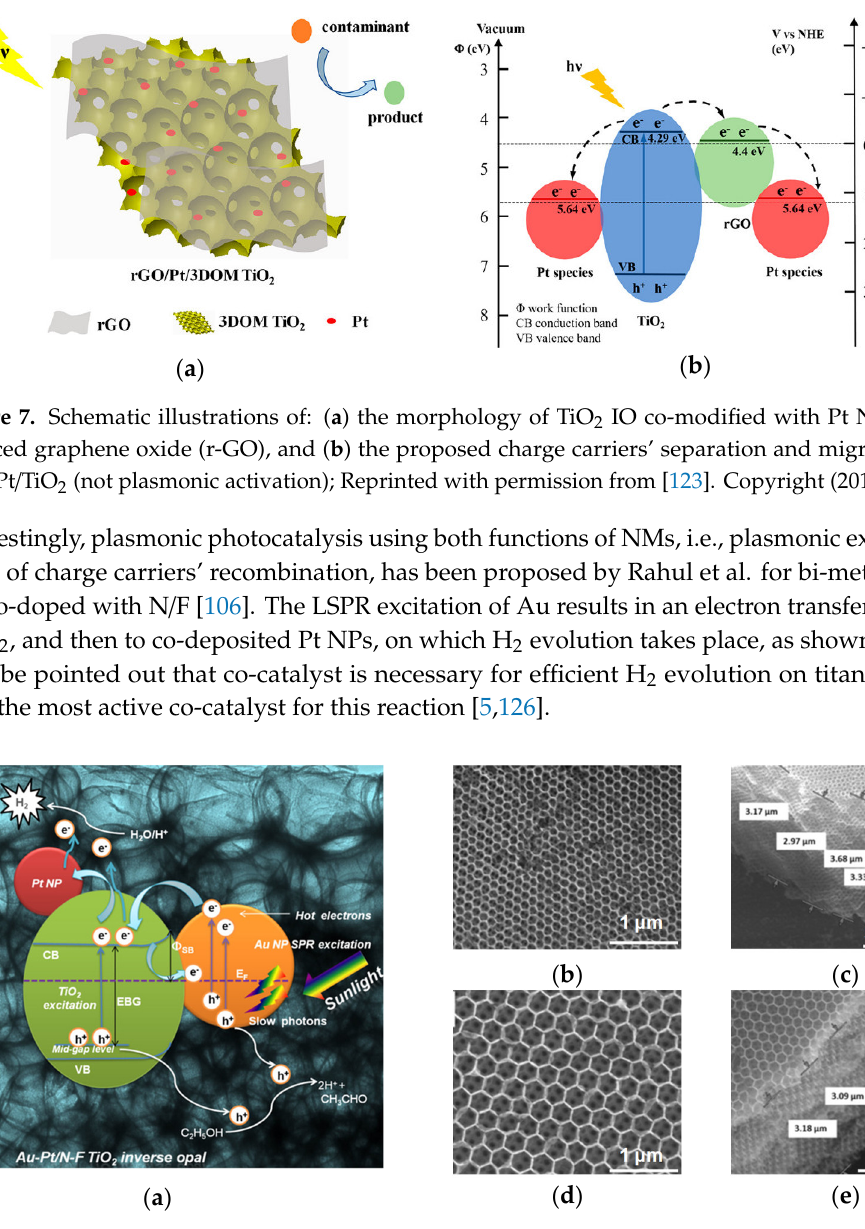
Figure 8. ( a ) Schematic illustration of the proposed mechanism of H 2 generation over Au-Pt / N-F TiO 2 IO-460 under solar light irradiation; SEM images of: ( b , c ) Au-Pt / N-F TiO 2 IO-215: ( b ) top view and ( c ) cross section view, and ( d , e ) Au-Pt / N-F TiO 2 IO-460: ( d ) top view and ( e ) cross section view; Reprinted with permission (after formatting) from [106]. Copyright (2018) WILEY.